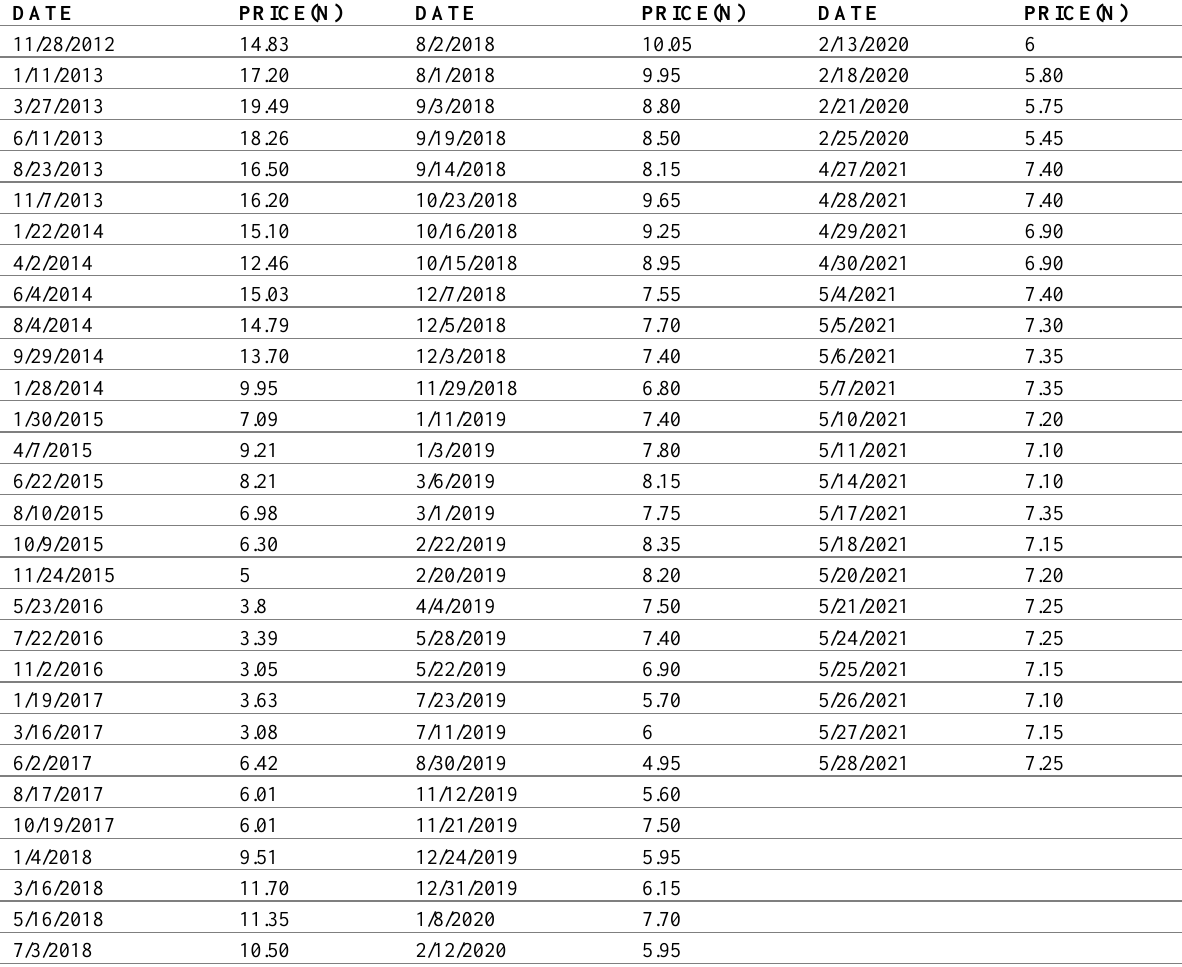
Table1: Review of Selected First Bank Share